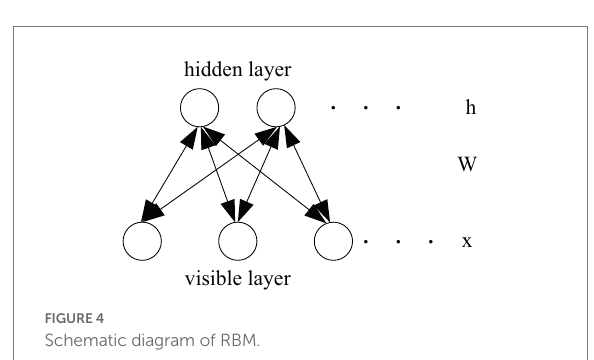
FIGURE 4 Schematic diagram of